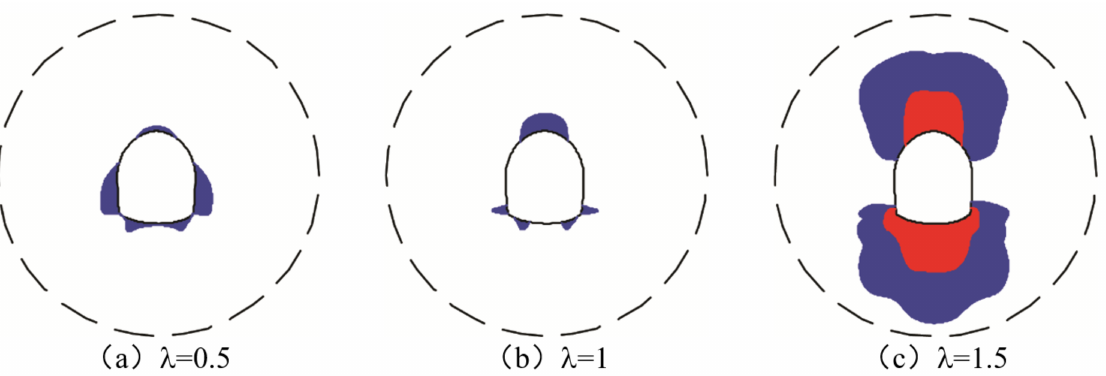
Figure 10. Range of strong and extremely strong rockburst in a single-track tunnel when σ v = 30 MPa.